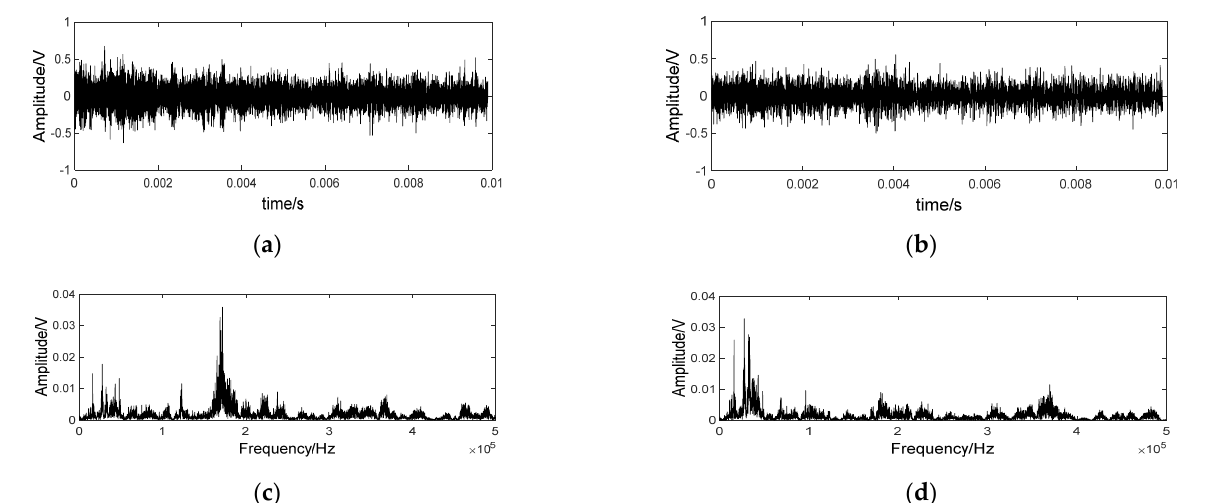
Figure 7. The output of different convolution kernel of the 5th node. ( a ) the output of the 1st kernel; ( b ) the output of the 2nd kernel; ( c ) the spectrum of the waveform in ( a ); ( d ) the spectrum of the waveform in ( b ).